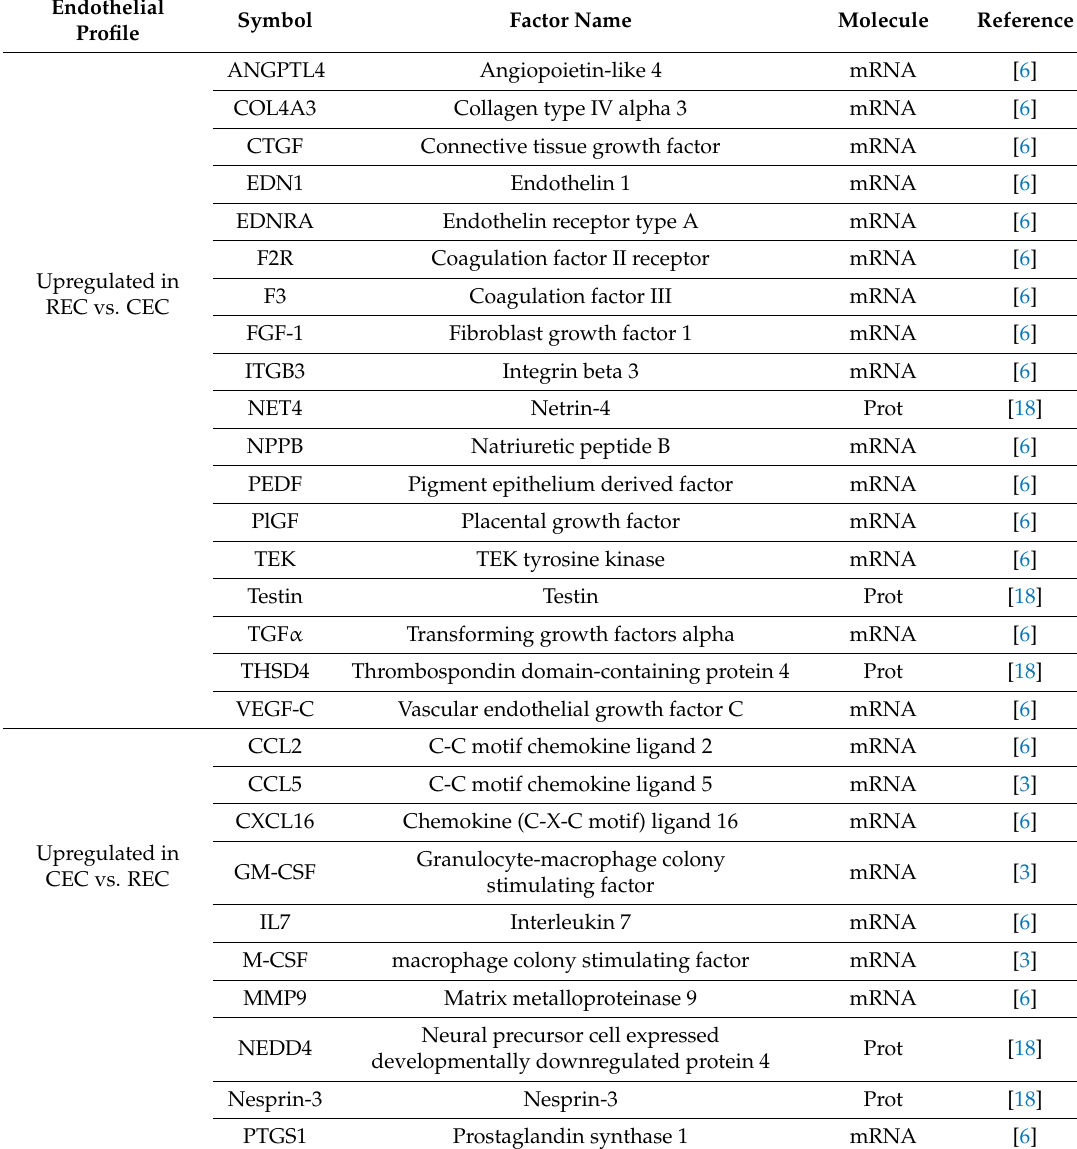
Table 1. Summary of differential molecular profile in retinal endothelial cell (REC) versus choroidal endothelial cell